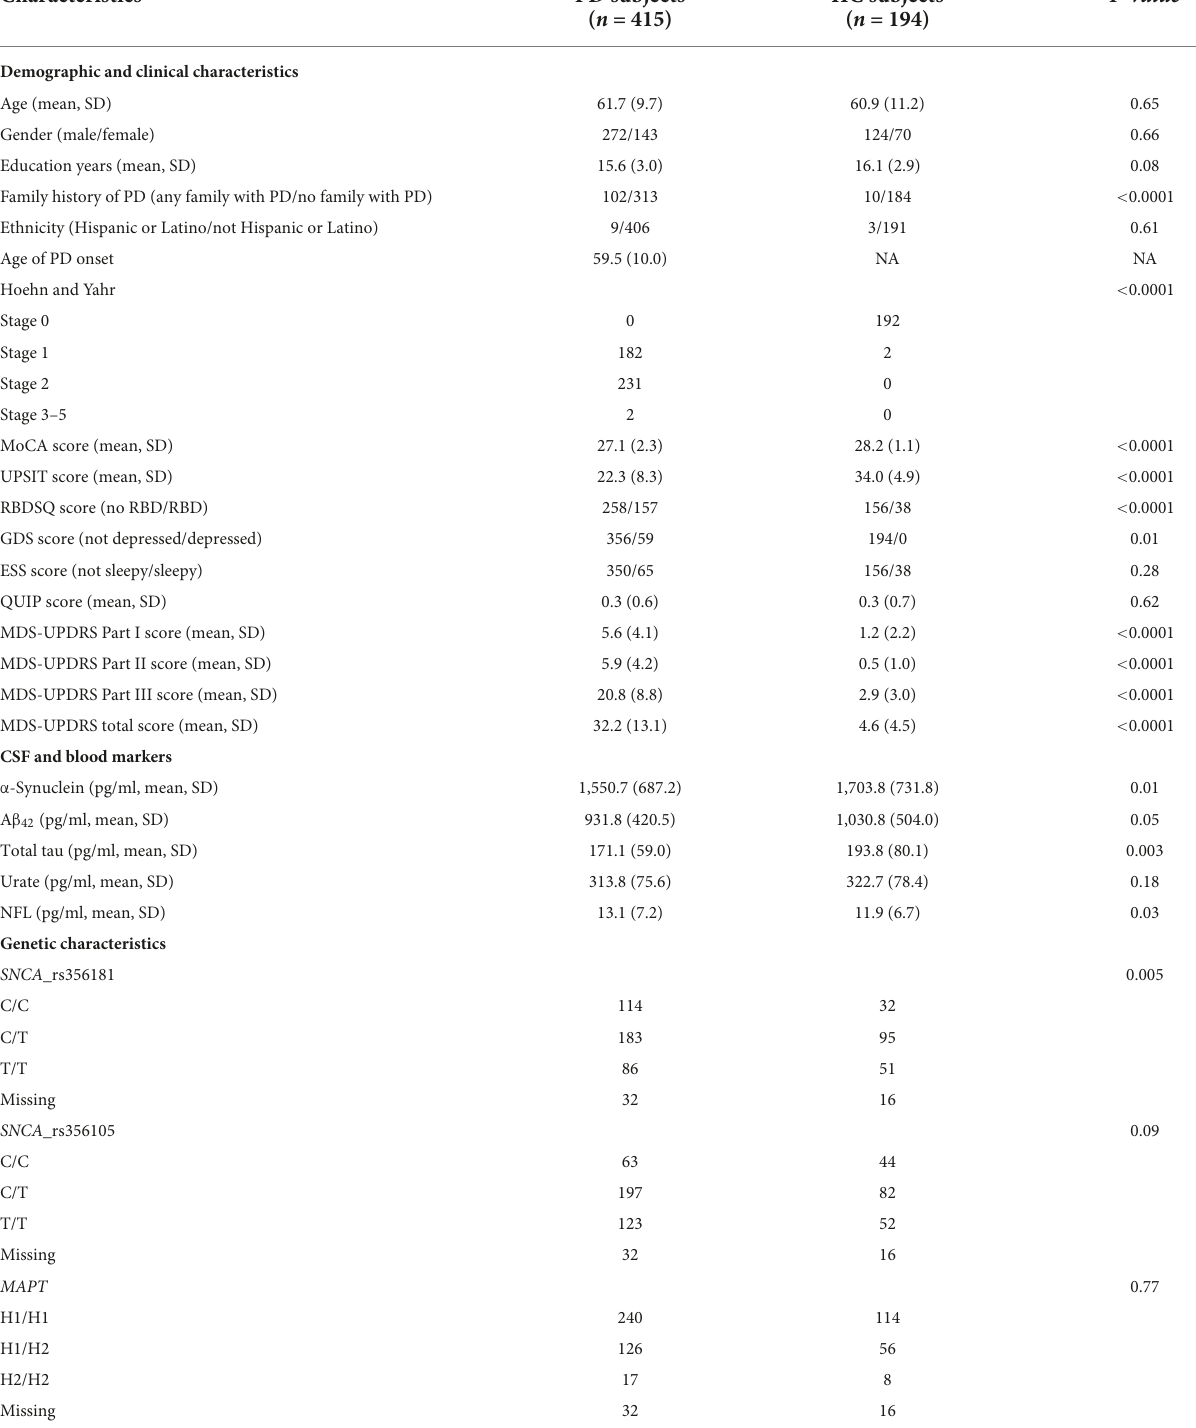
TABLE 1 Baseline demographic and disease characteristics of included participants.